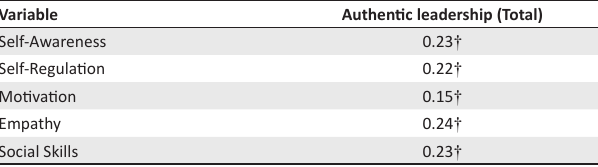
TABLE 4: Correlations between components of emotional intelligence and authentic leadership.